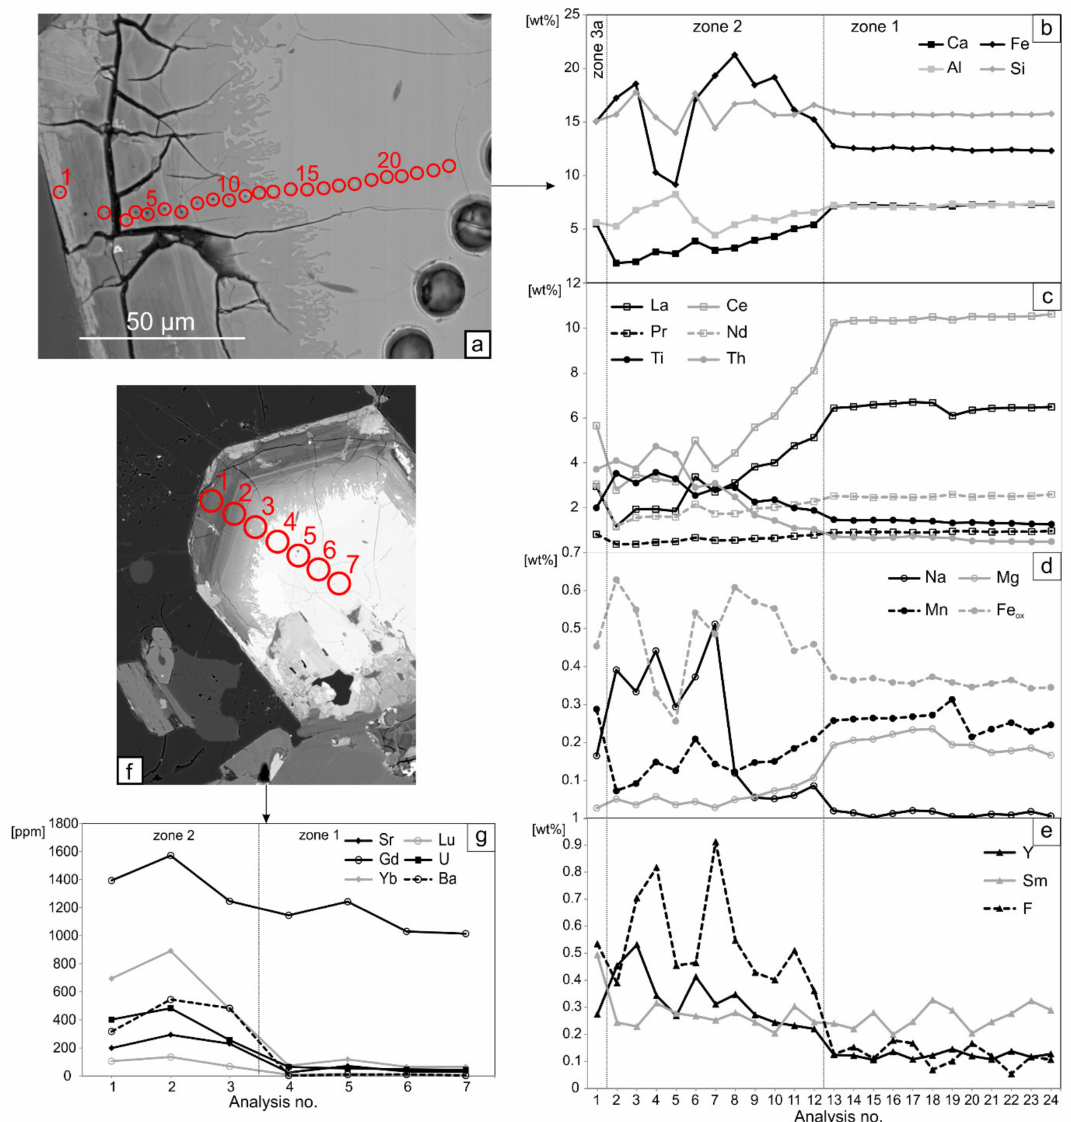
Figure 8. EPMA and LA-ICP-MS line profiles for grain GR-1, including zone 3a, 2, and 1; ( a ) BSE image of GR-1 with EPMA line profile; ( b – e ) diagrams showing element concentrations for all measured points in the EPMA profile; ( f ) BSE image of GR-1 with LA-ICP-MS profile; and ( g ) diagram showing element concentrations for seven points measured by